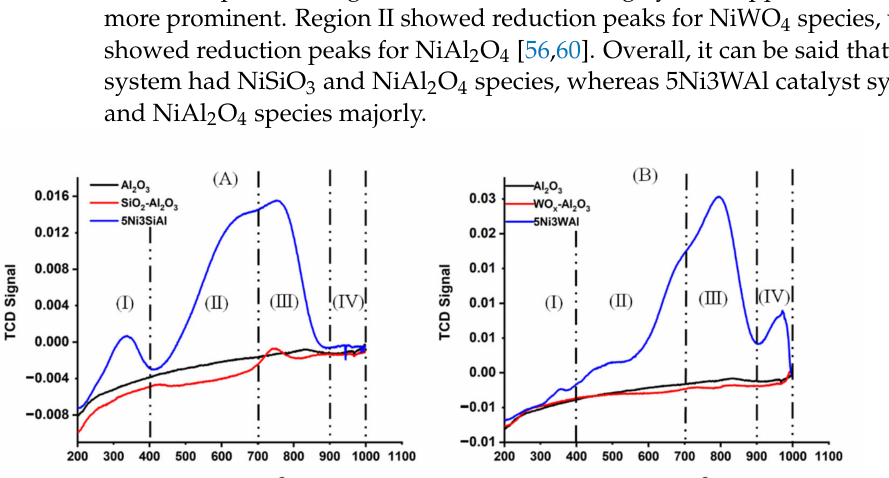
Figure 6. H 2 temperature-programmed surface reduction profiles of ( A ) Al 2 O 3 , 3SiAl, and 5Ni3SiAl catalysts, and ( B ) Al 2 O 3 , 3WAl, and 5Ni3WAl